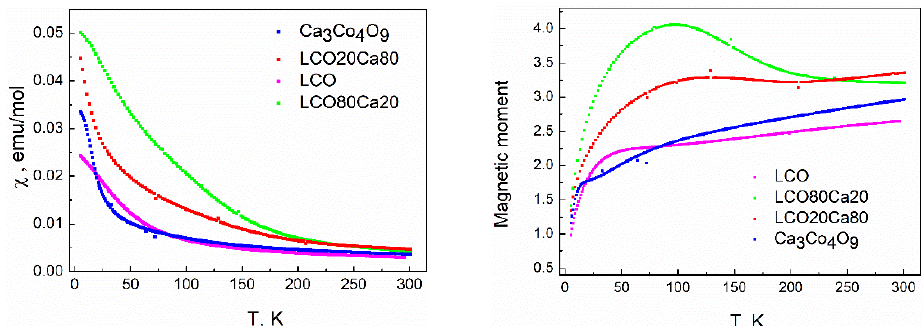
Figure 4. Temperature dependence of the magnetic susceptibility ( left ) and calculated effective magnetic moment ( right ) for the individual components and the composites between them.